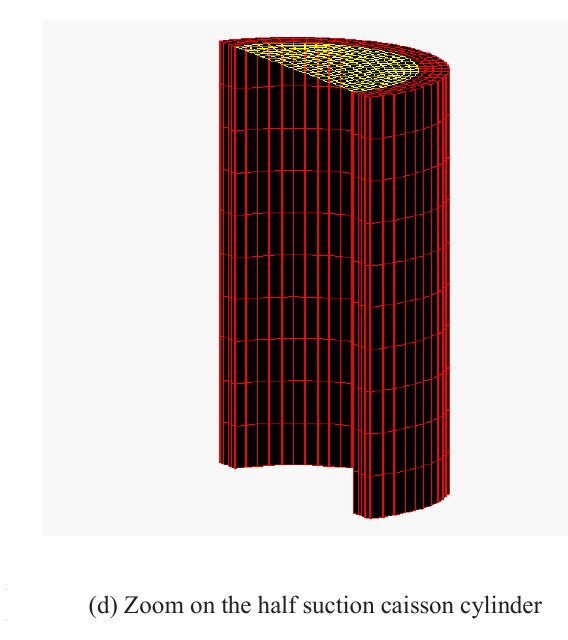
Figure 3 Used numerical model